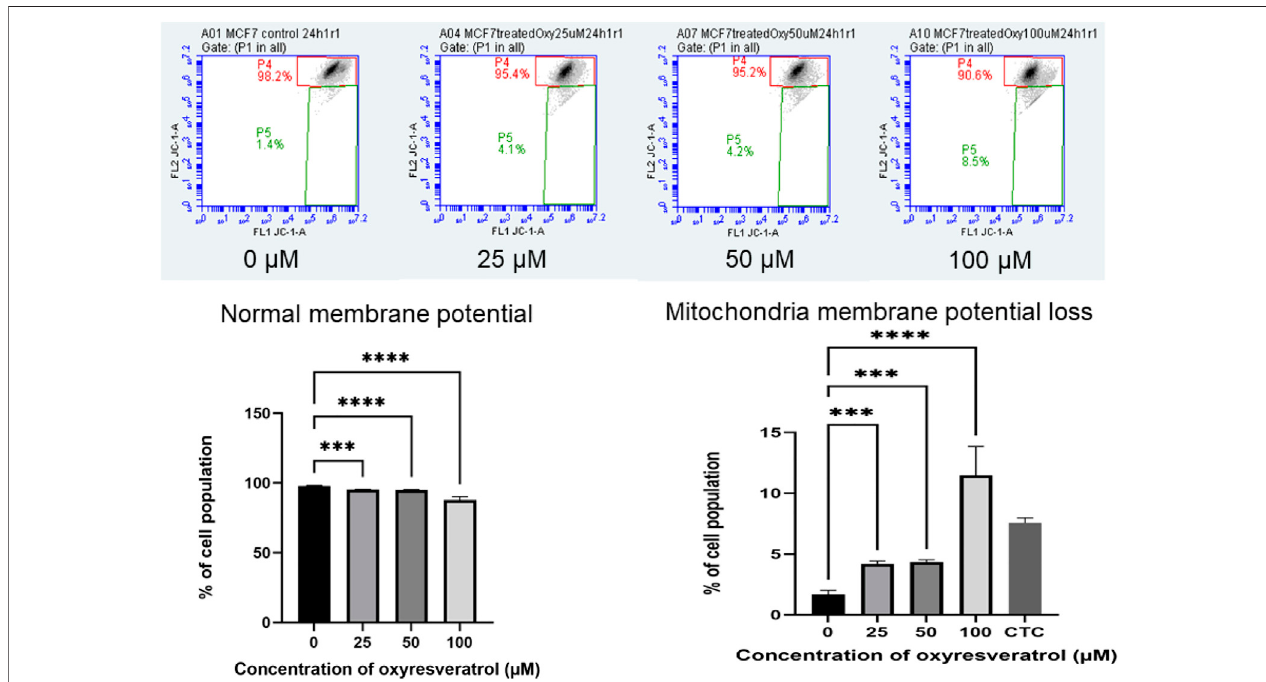
FIGURE 8 | Mitochondrial membrane potential of MCF-7 cells following exposure to various concentrations of OXY for 24 h and camptothecin (CTC) for 4 h. The cells were stained with JC – 1 and analyzed by fl ow cytometry. Data are the mean ± SD of three experiments. Statistical analysis was carried out using One-way ANOVA analysis of variance followed by Dunnett ’ s test. The signi fi cant difference was compared relatively to control (*** p < 0.001 and **** p < 0.0001).